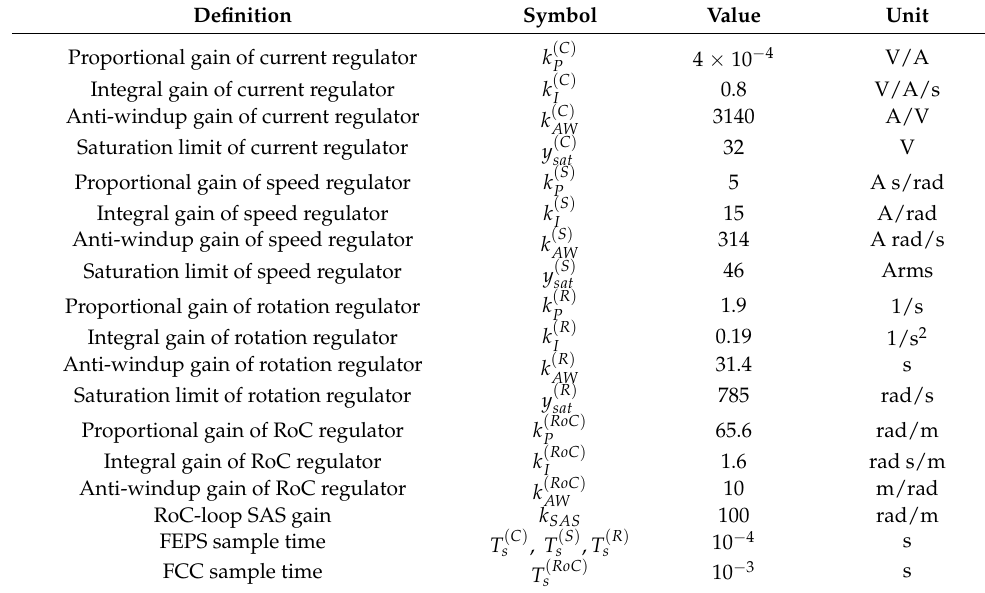
Table A3. FEPS and UAV regulators